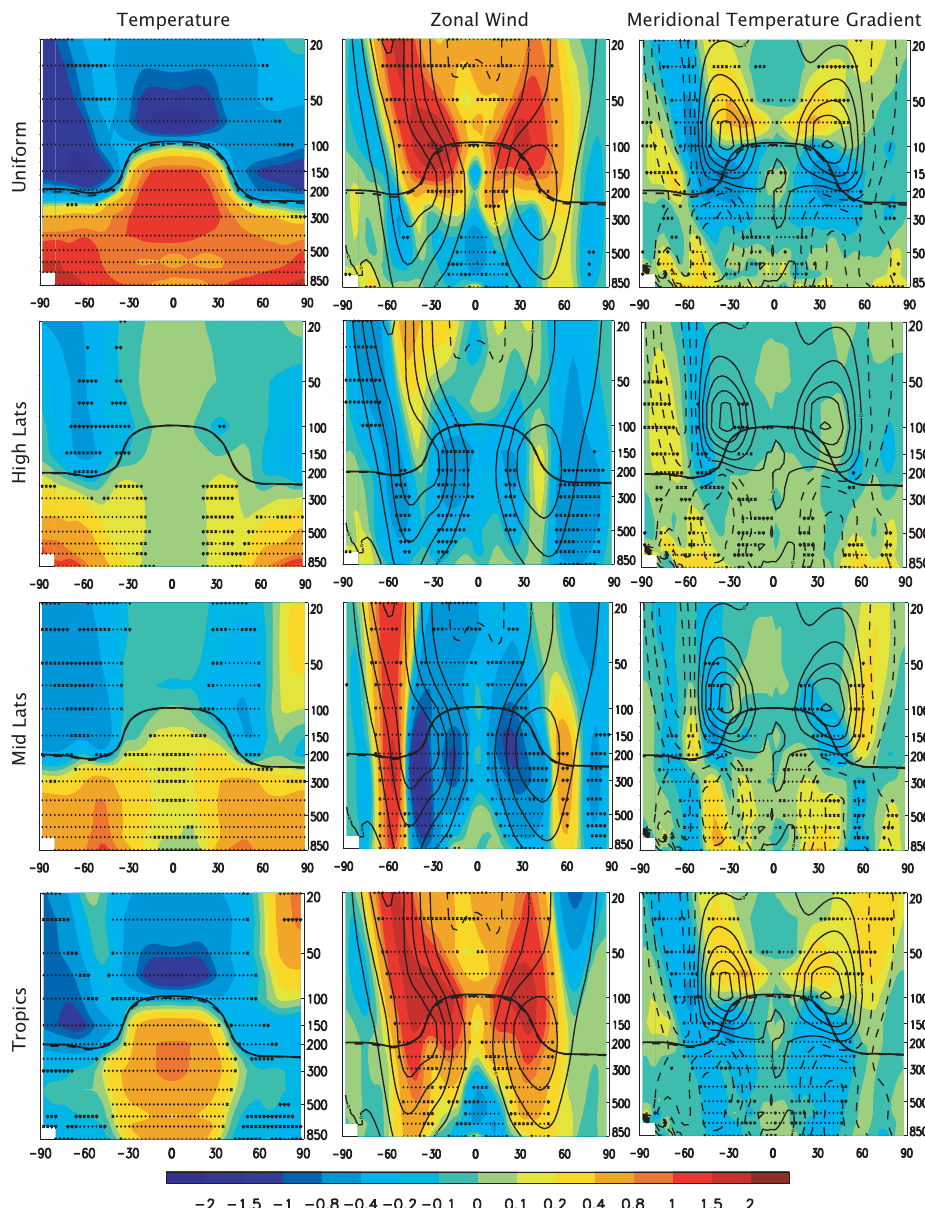
Fig. 3. As in Fig. 2, but based on the lower tropospheric heating (LTHT) experiments.